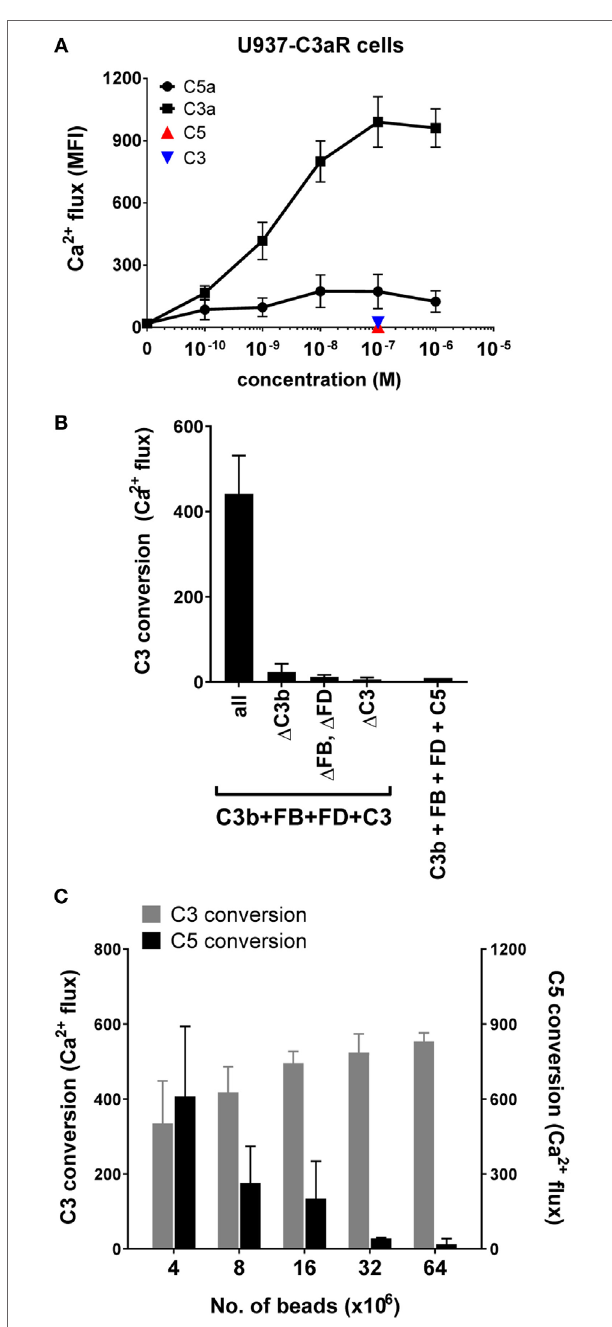
FigUre 2 | Development of an alternative pathway (AP) C3 convertase model. (a) C3a specifically induces calcium mobilization in U937-C3aR cells, while C3 and C5 do not. (B) C3 conversion by AP convertases on beads was analyzed in a calcium mobilization assay with U937-C3aR cells. C3a could only be detected in the sample supernatant in the presence of all AP components. C5 conversion in the AP model did not induce calcium flux in the U937-C3aR cells. (c) AP C3 and C5 conversion were performed on beads coated with different densities of C3b and analyzed by calcium mobilization assay with U937-C3aR and -C5aR cells, respectively. A high density of C3b molecules on the target surface enhances C5 but not C3 conversion. (a–c) Data of three independent experiments, presented as mean ±